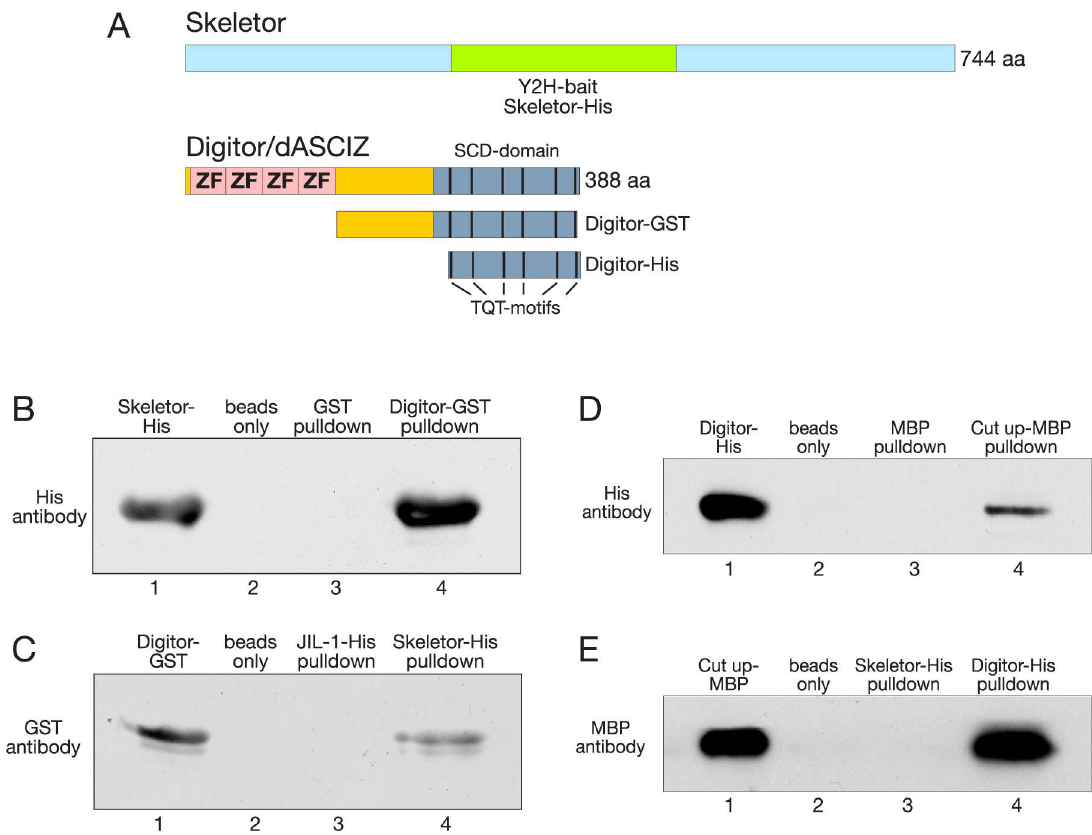
Fig 1. Digitor/dASCIZ interact with Skeletor and Cut up in pull down assays. (A) Diagramsof full-lengthSkeletor and Digitor/dASCIZ and the fragments used for yeast two-hybrid assays. The regionof Skeletorcorrespondingto the yeast two- hybrid(Y2H) bait and Skeletor-His is indicatedin green. Full-lengthDigitor/dASCIZ has four zinc-finger domains (ZN) and a SCD with six TQT-motifs and the two GST- and His-taggedCOOH-terminal fragments, respectively, are indicatedbelow. (B) A Digitor-GST construct pulls down Skeletor-His as detected by His antibody (lane 4). Beads-onlyand GST-only pulldown controls were negative (lane 2 and 3). Lane 1 shows the position of the Skeletor-Hisfusion protein. (C) A Skeletor-His construct pulls down Digitor-GST as detected by GST antibody(lane 4). Beads only and JIL-1-Hispulldowncontrols were negative(lane 2 and 3). Lane1 shows the positionof the Digitor-GST fusion protein. (D) A Cut up-MBP construct pulls down Digitor-His as detected by His antibody (lane 4). Beads only and MBP only pulldowncontrols were negative(lane 2 and 3). Lane 1 shows the positionof the Digitor-His fusion protein. (E) A Digitor-Hisconstruct pulls down Cut up-MBP as detected by MBP antibody(lane 4). Beads-only and Skeletor-His pulldowncontrols were negative (lane 2 and 3). Lane1 shows the positionof the Cut up-MBP fusion